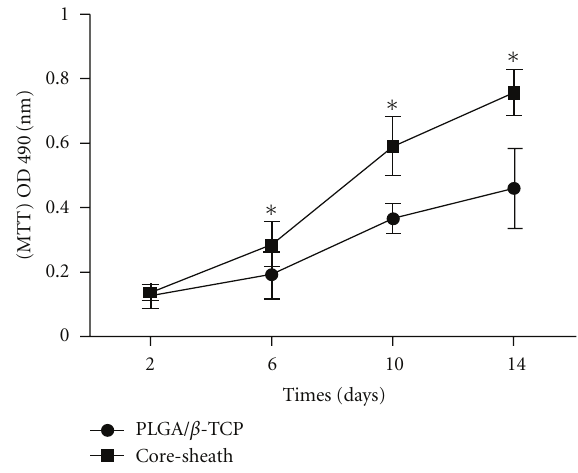
Figure 2: Cell proliferation comparisons on the core-sheath structure composite sca ff old and the PLGA/ β -TCP skeleton. Cell proliferation analysis by MTT methods. Each value and error bar represent the mean of triplicate samples and their standard deviation ( ∗ P < 0 . 05 compared with the PLGA/ β -TCP sca ff olds; n =